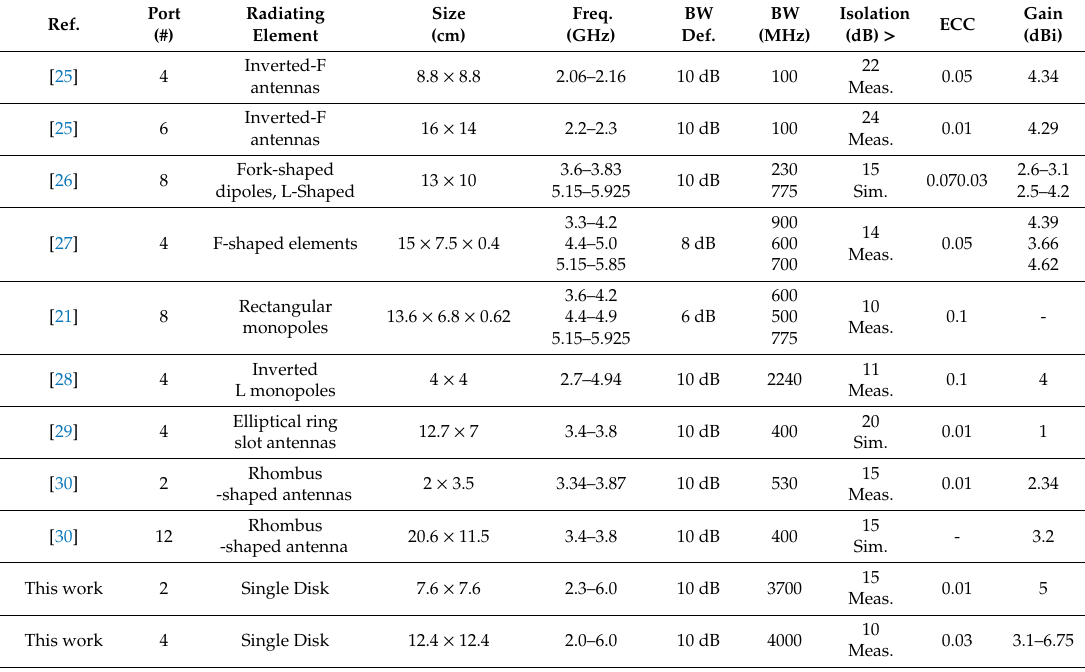
Table 2. Comparison of proposed antennas in this work and antennas in